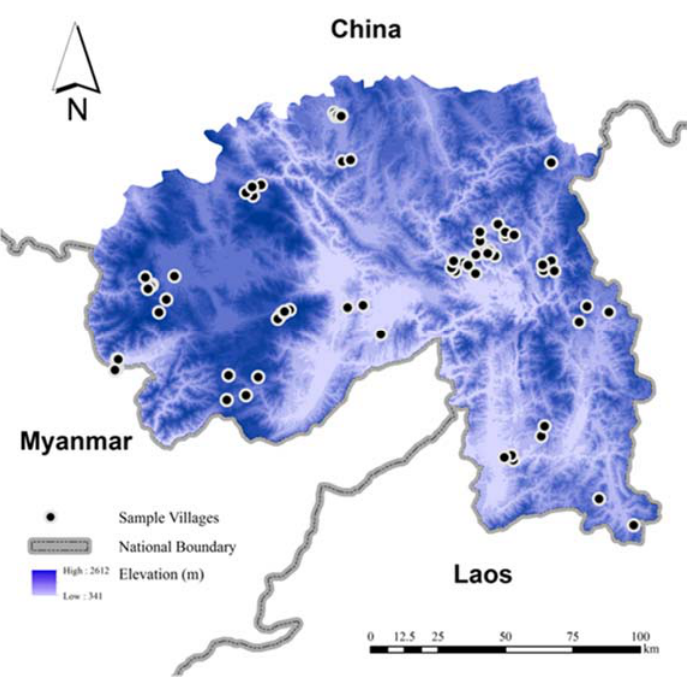
Figure 1. Locations of sampled villages in Xishuangbanna, southwest (SW) China.